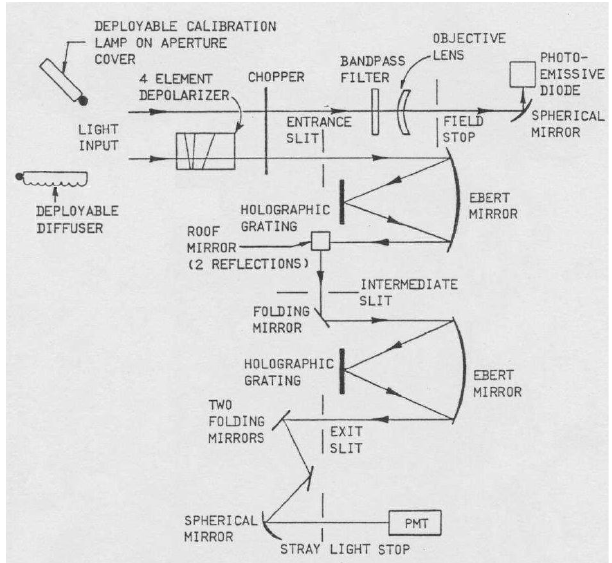
2 Figure 3 . Diagram of SBUV/2 instrument optics. SBUV(/2) instruments consists of double 3 Fig. 3. Diagram of SBUV/2 instrument optics. SBUV(/2) instru- ments consist of double Ebert monochromators for scanning ozone Ebert monochromators for scanning ozone absorption wavelengths, and a bandpass-filter 4 absorption wavelengths, and a bandpass-filter photometer as a photometer as a cloud cover monitor. A depolarizer is installed in front of the monochromator to 5 cloud cover monitor. A depolarizer is installed in front of the minimize the polarization effect with atmosphere Rayleigh scattering coupled with strong 6 monochromator to minimize the polarization effect with atmo- polarity with the grating spectrometer. Courtesy Ball Aerospace and Technologies Corp. 7 spheric Rayleigh scattering coupled with strong polarity with the grating spectrometer. Courtesy of Ball Aerospace and Technologies